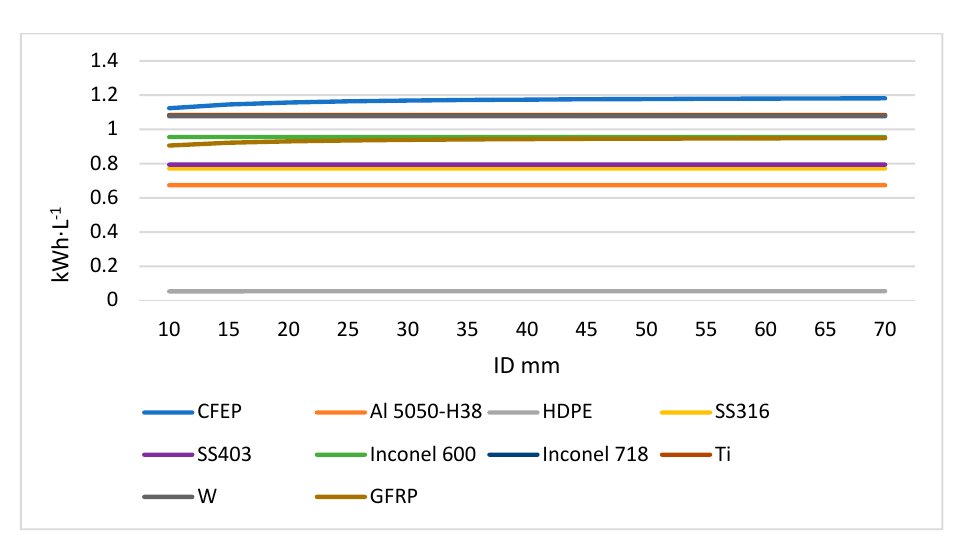
Figure 6. VED of spheres made of several materials with ID from 10 up to 70 mm, at 700 daN cm − 2 of inside pressure.